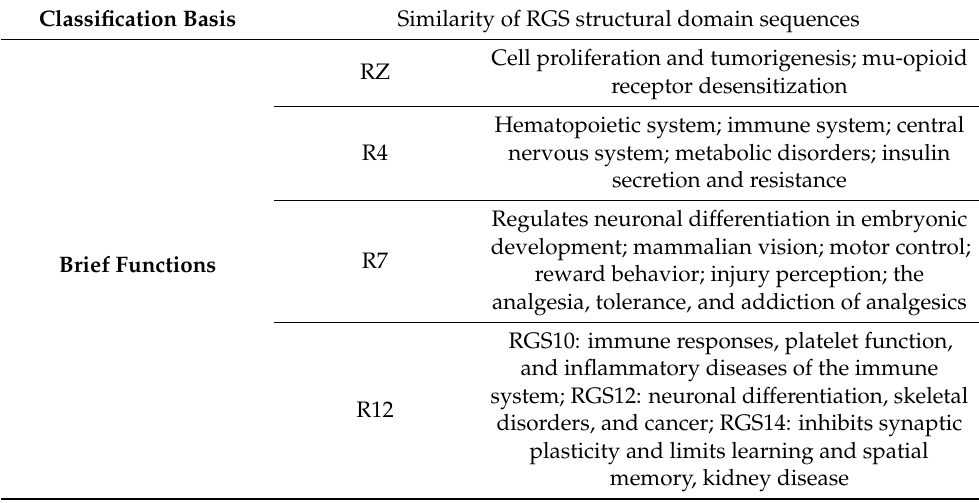
Table 1. Brief functions of the RGS